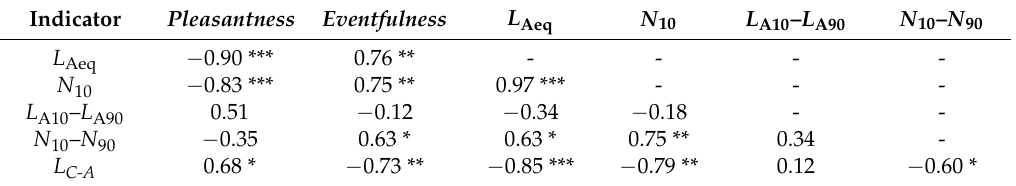
Table 3. Pearson’s coefficient of correlation amount soundscape indicators and descriptors for